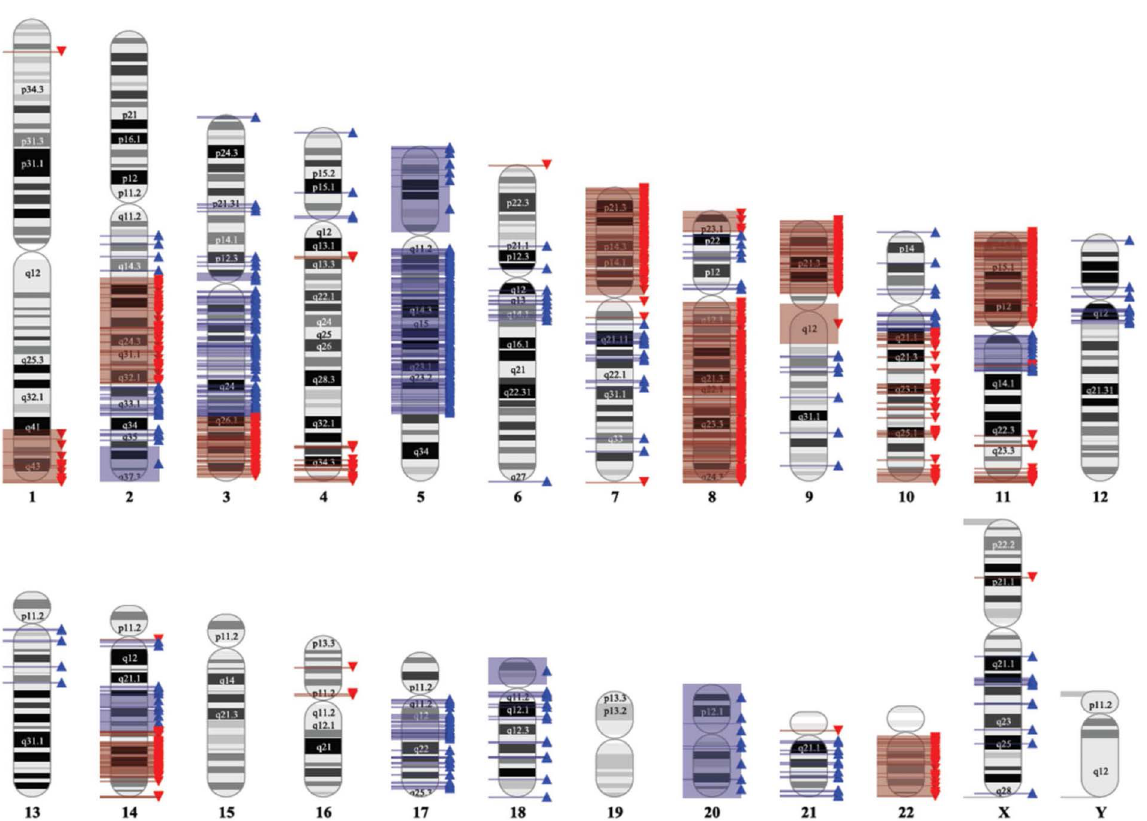
Figure 6. Chromosomal imbalances detected in the LX-2 cell line using a SNP 6.0 Array. Gains and losses are shown by red and blue triangles, respectively.